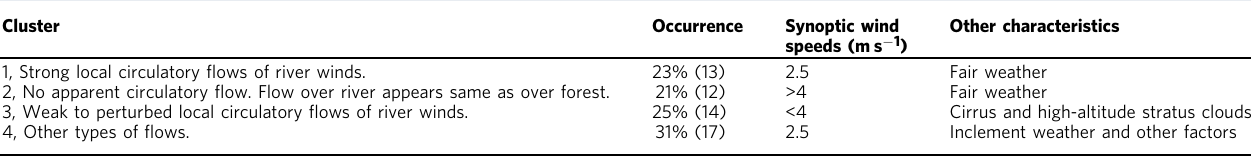
The parenthesized numbers indicate how many pro fi les out of 56 occurred in each